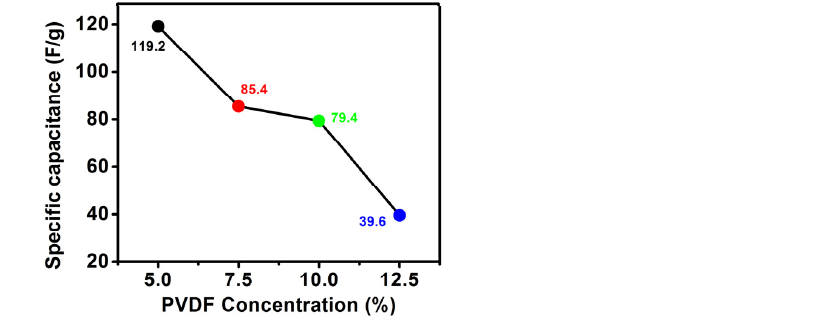
Figure 6. Calculated specific capacitance of electrodes for different PVDF concentration.